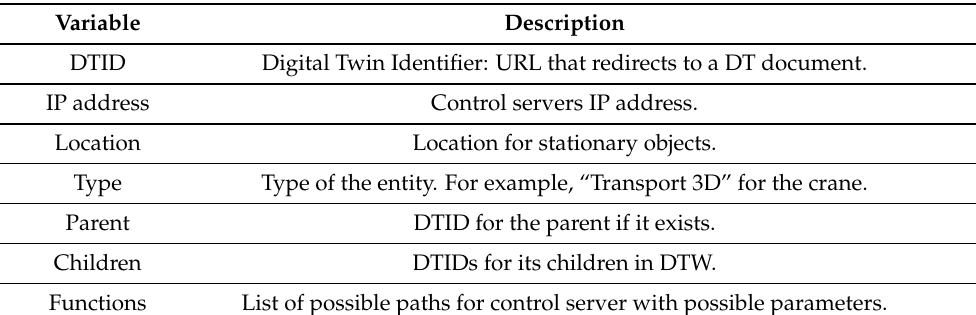
Table 2. Table of variables in a DT document and their descriptions.